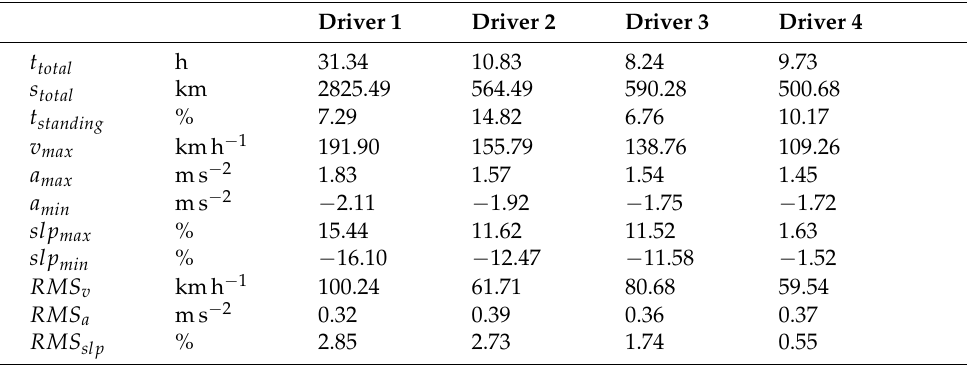
Table 2. Available data for training driver